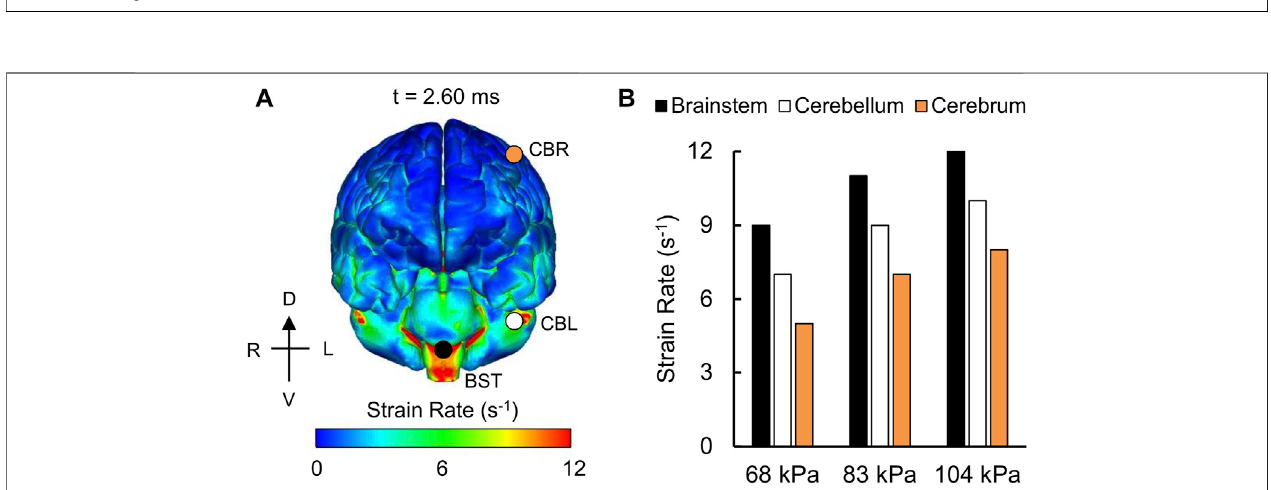
FIGURE6 | Simulation showing the variation ofthe strain rate asafunction of brainlocation. (A) Contourmap showing themodel-predicted strain-rate distribution throughout the outer surface of the brain for the 104 kPa blast overpressure at t (cid:1) 2.60 ms into the simulation. CBR: cerebrum (orange circle); CBL: cerebellum (white circle);BST:brainstem (black circle). (B) Bargraph comparingthepeak strain ratesfor the68, 83, and 104 kPa blastoverpressures. D: dorsal; V: ventral; R: right; L: left.